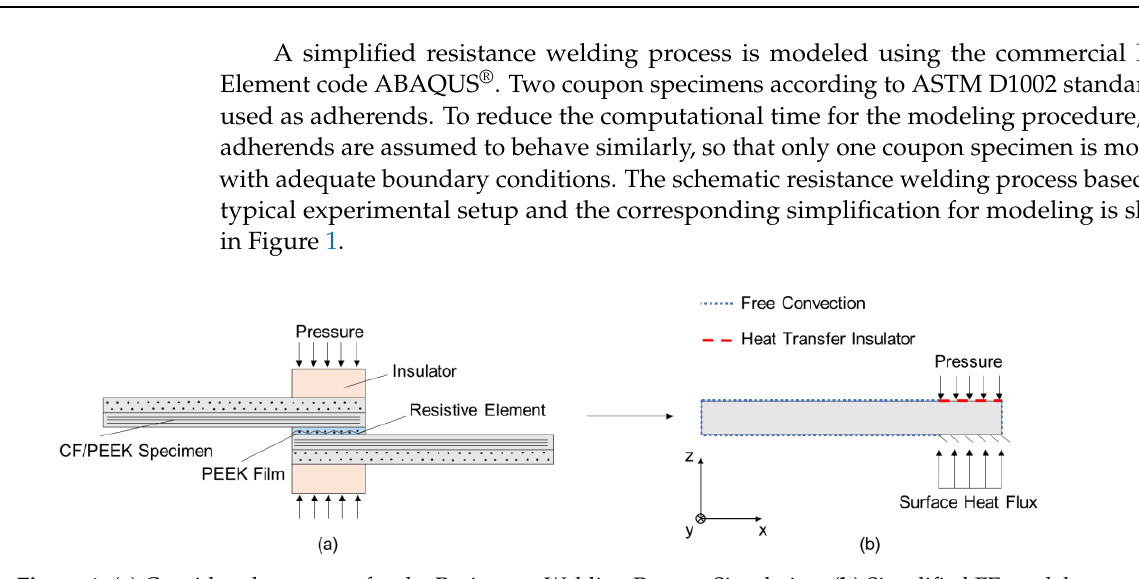
Figure 1. ( a ) Considered geometry for the Resistance Welding Process Simulation; ( b ) Simplified FE model.